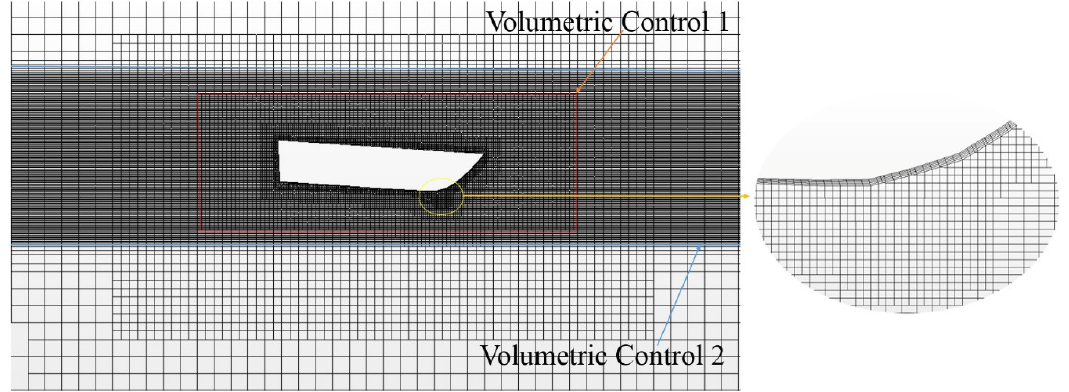
Figure 7. Mesh encryption around the hull: Volumetric Controls 1 and 2; Prismatic mesh around the hull.